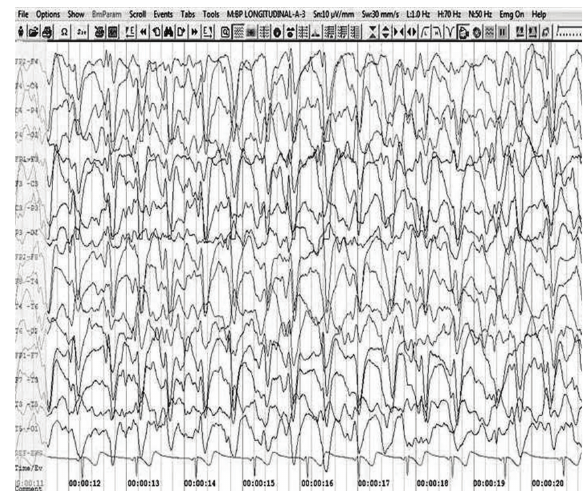
Figure 1: Scalp electroencephalogram showing disorganized back- ground with generalized spike-wave discharges 2–2.5/second occu- pying more than 80% of tracing, consistent with nonconvulsive status epilepticus (Case 1).